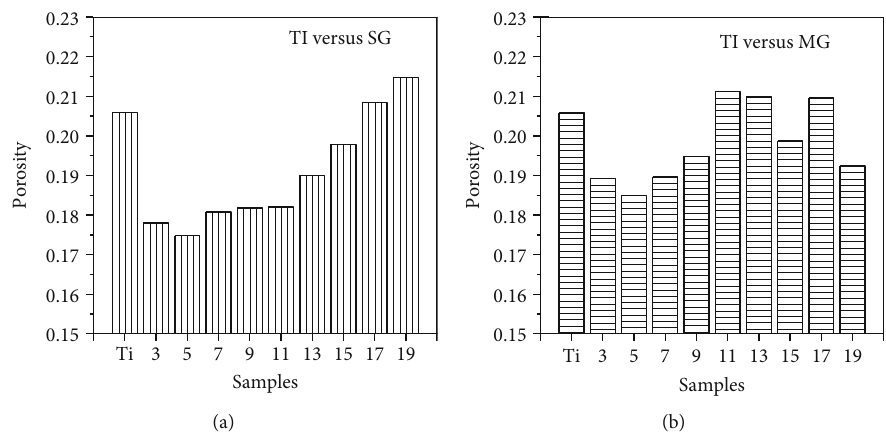
Figure 8: Porosity of the simulation realizations: (a) single-grid scheme; (b) multiple-grid scheme.